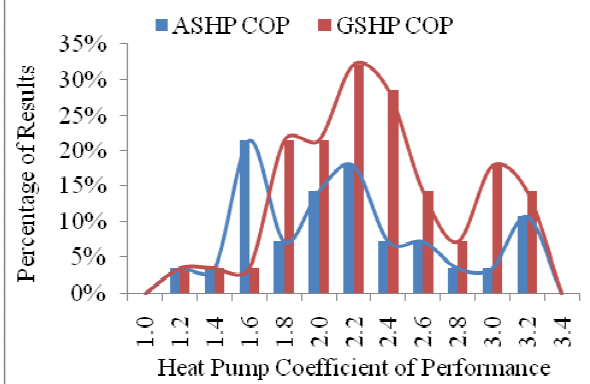
Figure 1. Energy Saving Trust (EST) field trial results. Data derived from